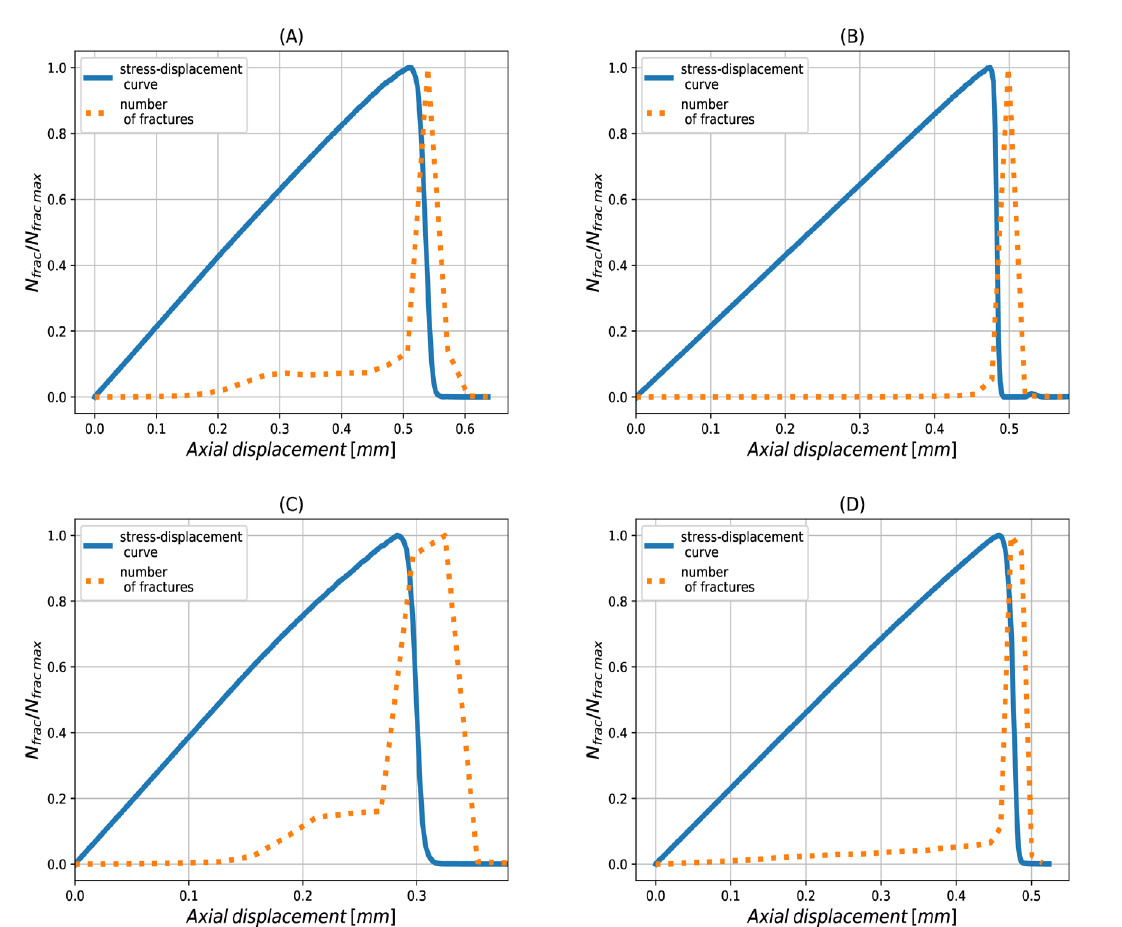
/N - number of fractures divided by maximum number of fractures) as a function of axial frac frac max